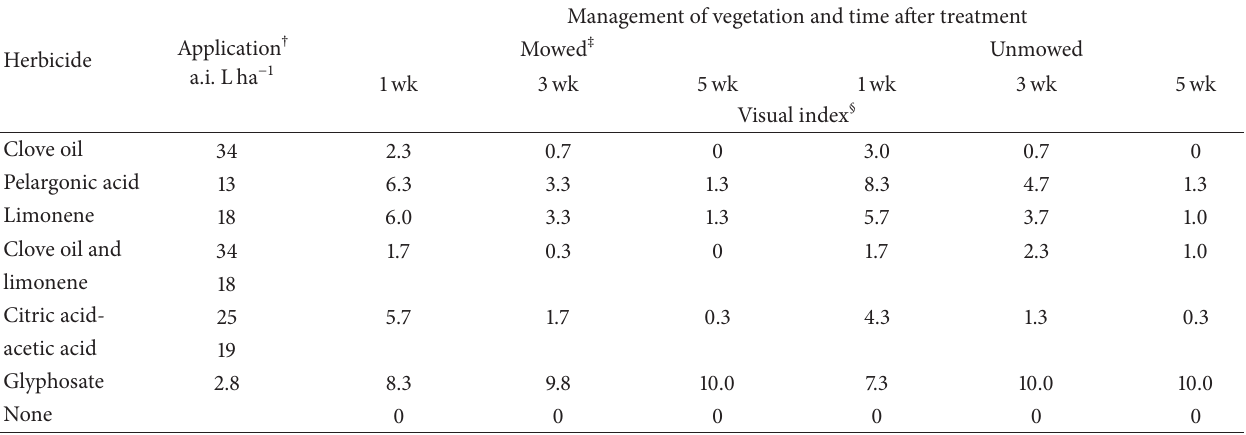
Table 12: Assessment of control of vegetation by alternative herbicides and a conventional herbicide applied to mowed or unmowed roadside plots (Roadside Experiment 2).